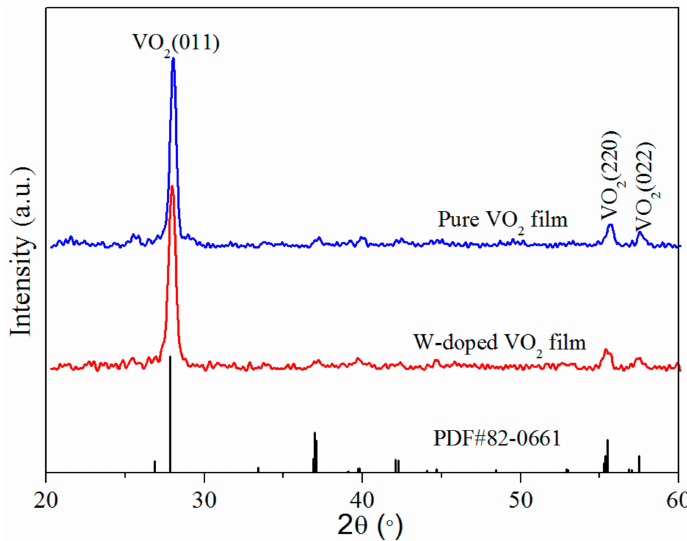
Figure 3. XRD patterns of the pure and W-doped VO 2